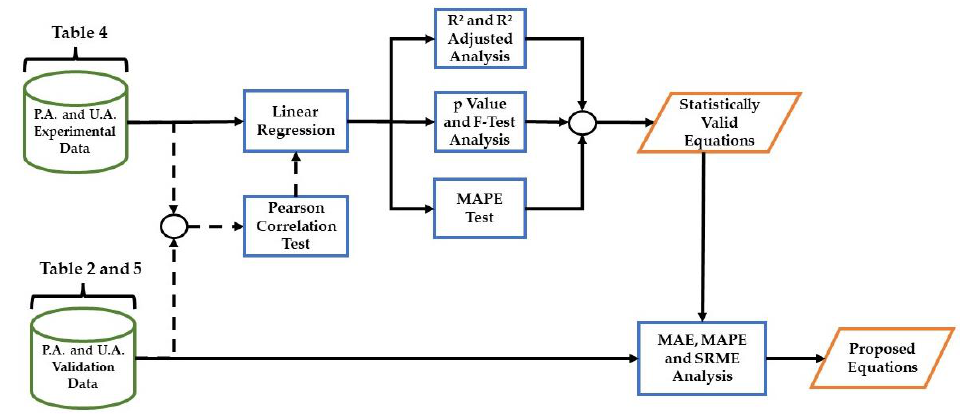
Figure 1. Flowchart of the adopted methodological process.